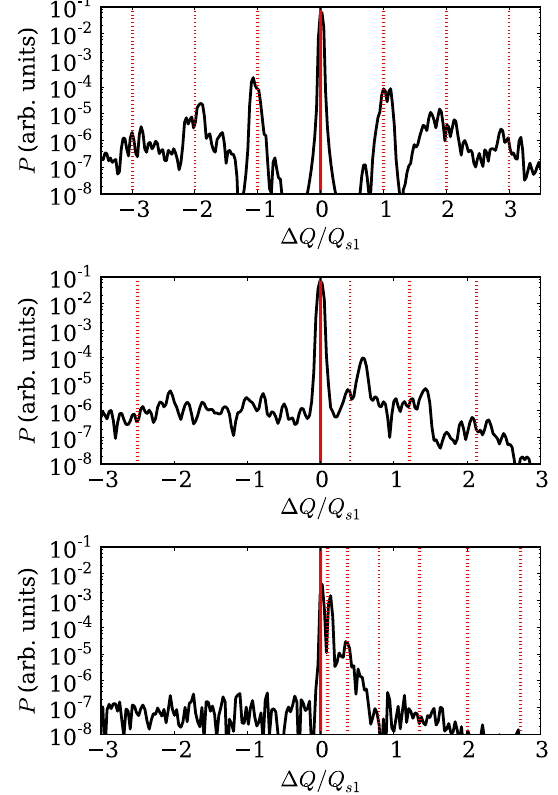
FIG. 1. Tune spectra obtained from the simulation for q sc ¼ 0 (top), q sc ¼ 2 (middle), and q sc ¼ 10 (bottom).